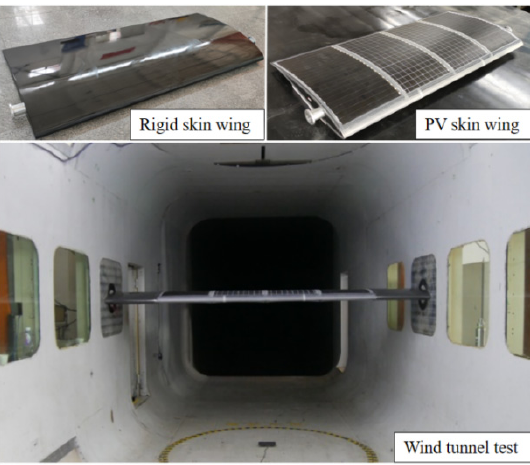
Figure 3. Wind tunnel tests of wings with different skin materials.